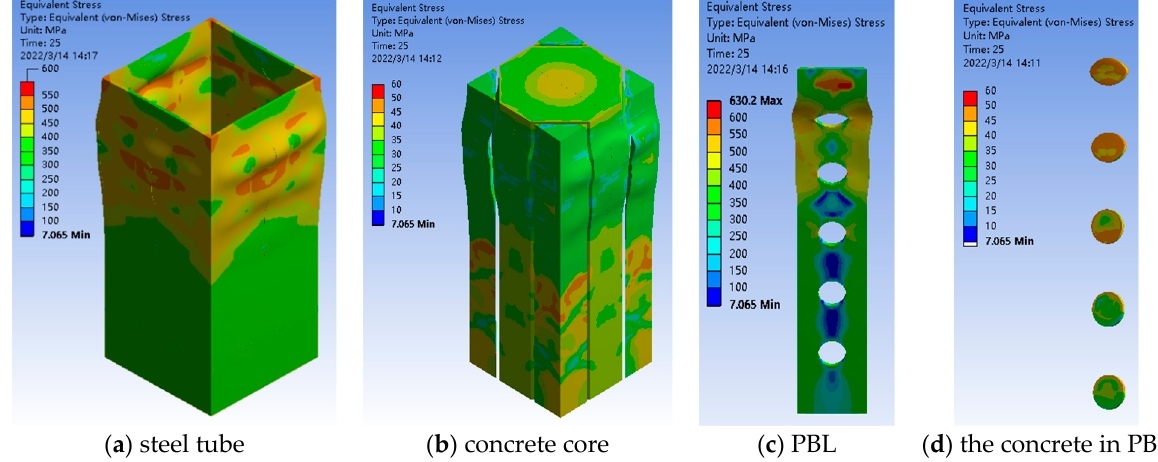
Figure 11. Failure mode and the equivalent stress of Type D.